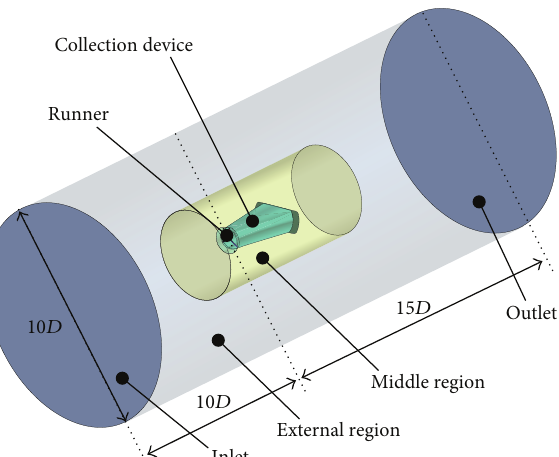
Figure 6: Computational